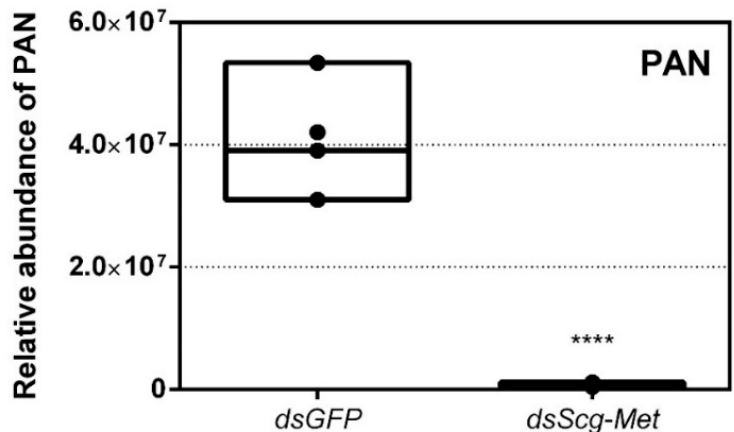
Figure 4. Relative abundance of PAN released by dsGFP and dsScg-Met injected adult male desert locusts 26 days after the adult molt. The emission of PAN was significantly reduced when Scg-Met was silenced. Data points are represented in a column graph as a floating bar (min to max value) with a line indicating the median. Significant differences (Student’s T-test) are indicated with asterisks (**** p < 0.0001). For each condition five individual animals were analyzed. PAN emission was measured by gas chromatography–mass spectrometry (GC–MS). (Abbreviations: ds = double stranded, Scg = Schistocerca gregaria , GFP = Green Fluorescent Protein, Met = Methoprene-tolerant, PAN = phenylacetonitrile).